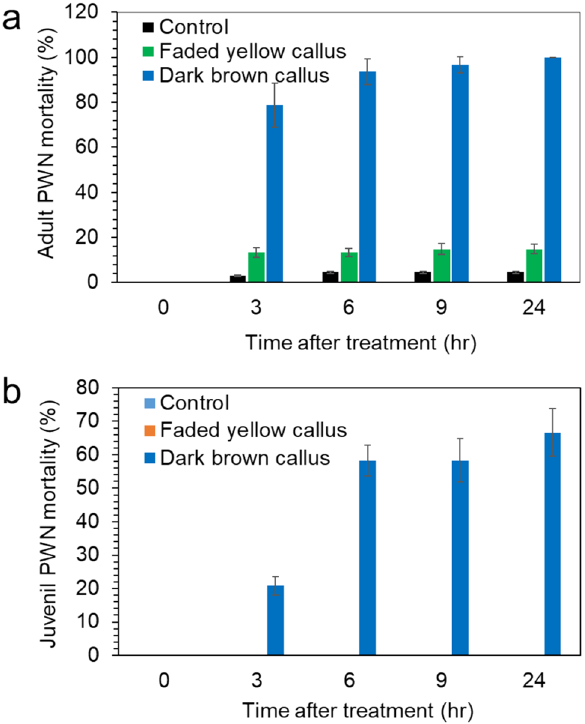
Figure 8. High nematicidal effects of P. strobus of aged dark brown callus extracts against PWNs. ( a ) Nematicidal effects of P. strobus callus extracts against adult PWNs during 24 h incubation. ( b ) Nematicidal effects of P. strobus callus extracts against juvenile PWNs during 24 h incubation. The concentrations of DPME and PME in the dark brown callus extract were adjusted to 120 µg/mL and 5.16 µg/mL, respectively.